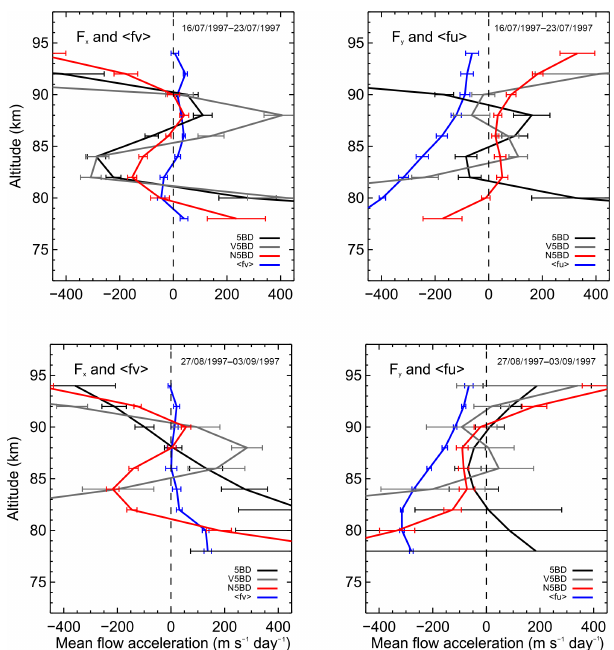
Figure 13. As per Fig. 12, for the October 1997 (upper panels) and June 1998 (lower panels)